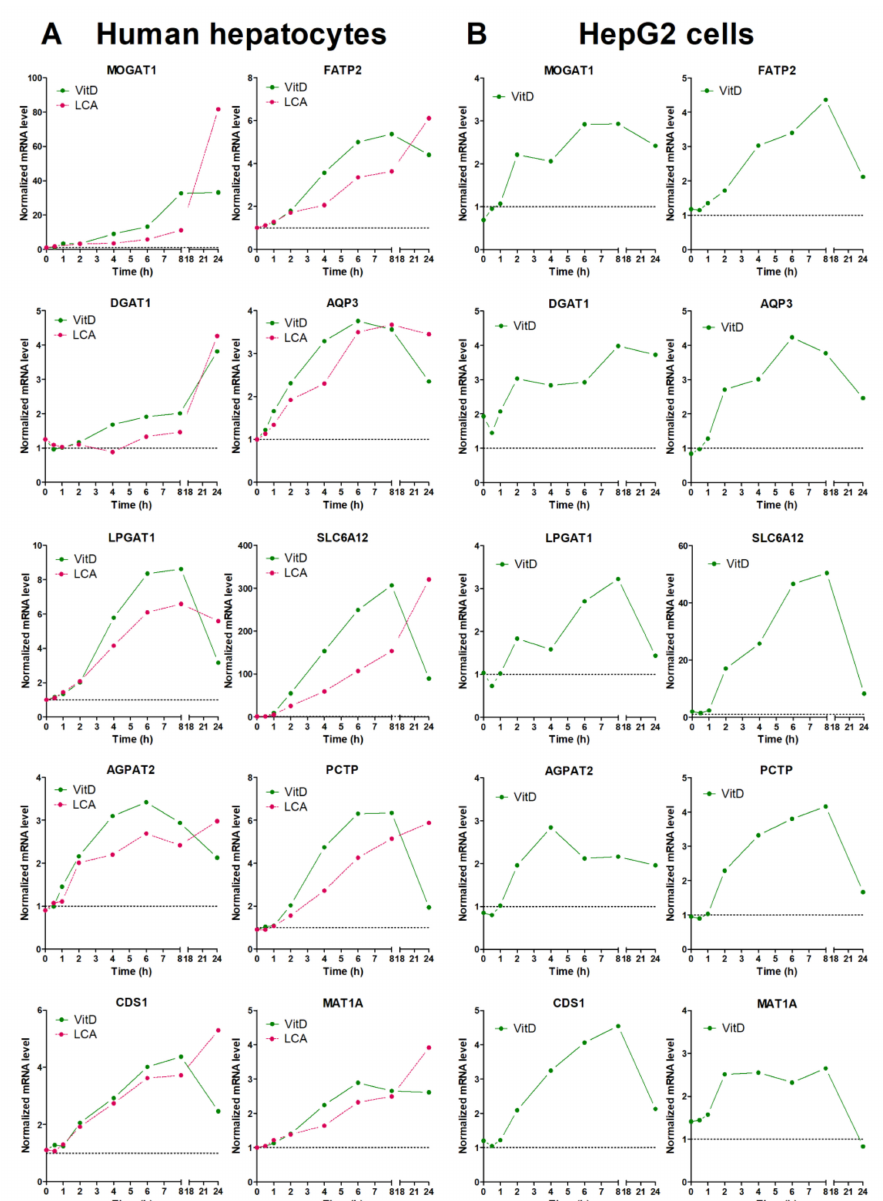
Figure 3. Time-course response to VitD and LCA of novel VDR-responsive genes. Cultured upcyte hepatocytes ( A ) or HepG2 cells ( B ) were infected with Ad-VDR and, 48 h later, 10 nM VitD or 100 µ M LCA was incorporated for di ff erent times. mRNA levels were determined by RT-qPCR and normalized with the housekeeping PBGD & RPLP0 mRNAs. Data represent the expression level relative to cells transfected with the control adenovirus (dotted line =